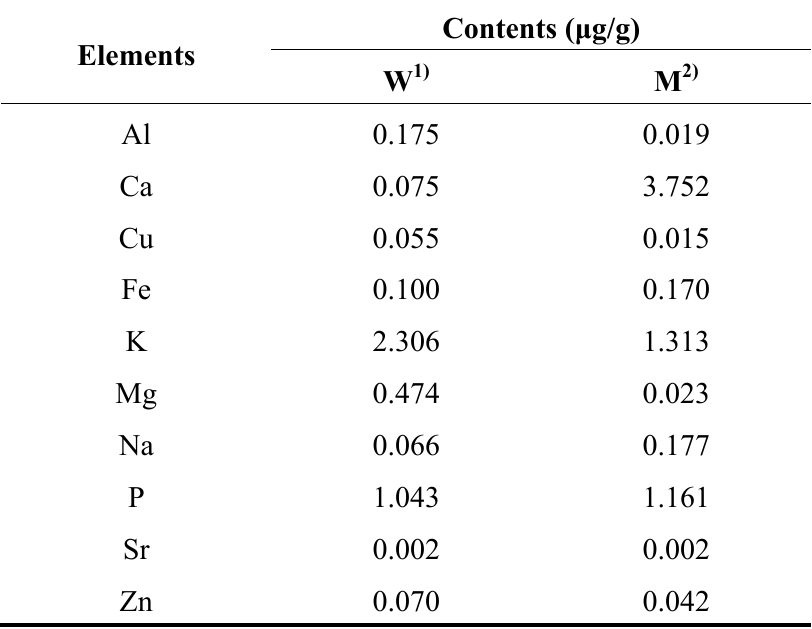
Table 1. Mineral contents of extracts from Carthamus